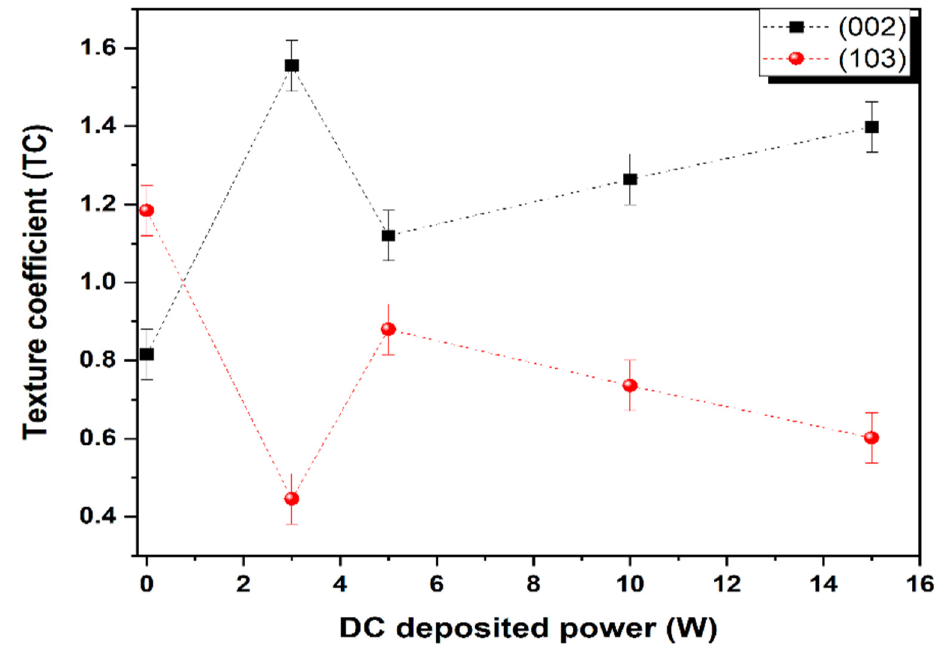
Figure 3. Texture coefficient, TC, for (002) and (103) plans of ZO, Fe-doped ZO deposited at different DC power.